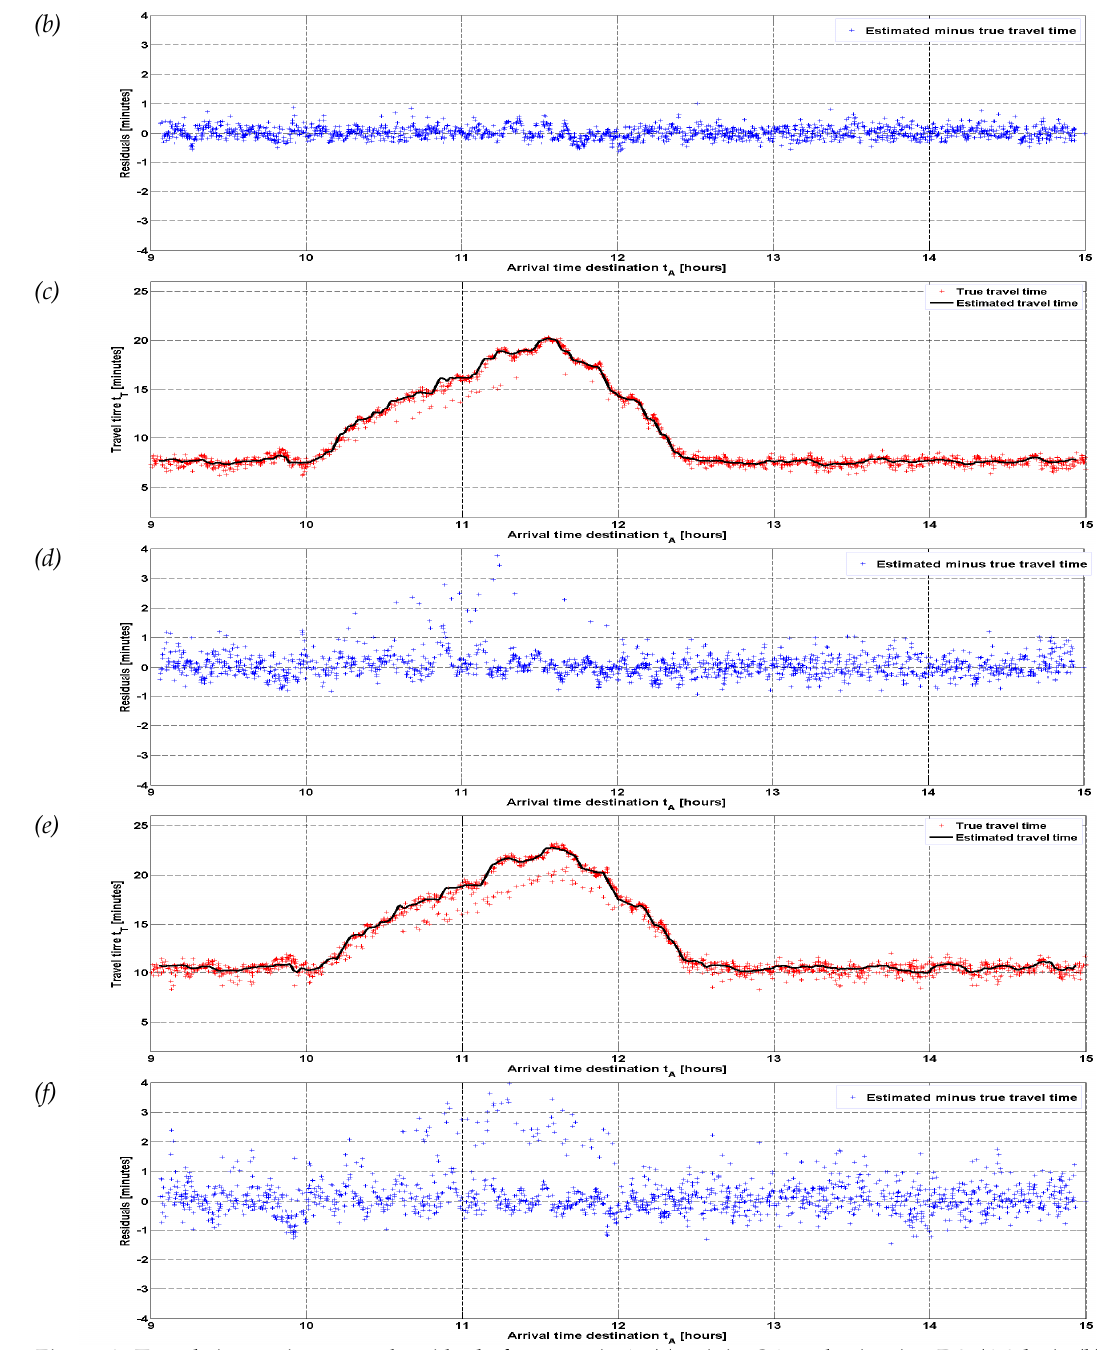
Figure 8. Travel time estimates and residuals for scenario 1: (a) origin O1 to destination D2 (4.8 km), (b) residual of estimates in Figure 8a, (c) origin O1 to destination D4 (9.3 km), (d) residuals of estimates in Figure 8c, (e) origin O1 to destination D6 (12.8 km), (f) residuals of estimates in Figure 8e. In Figures 8a, 8c, and 8e the red crosses indicate true travel times of individual vehicles and the black line represents the estimated travel times as a function of the downstream arrival time. In Figures 8b, 8d, and 8f the blue crosses indicate the residuals of the travel times, i.e. estimated minus true travel times. In Figure 8 we see, that for all three OD-combinations the estimated travel time (black line) matches the true travel times (red crosses) well, almost independently of the distance